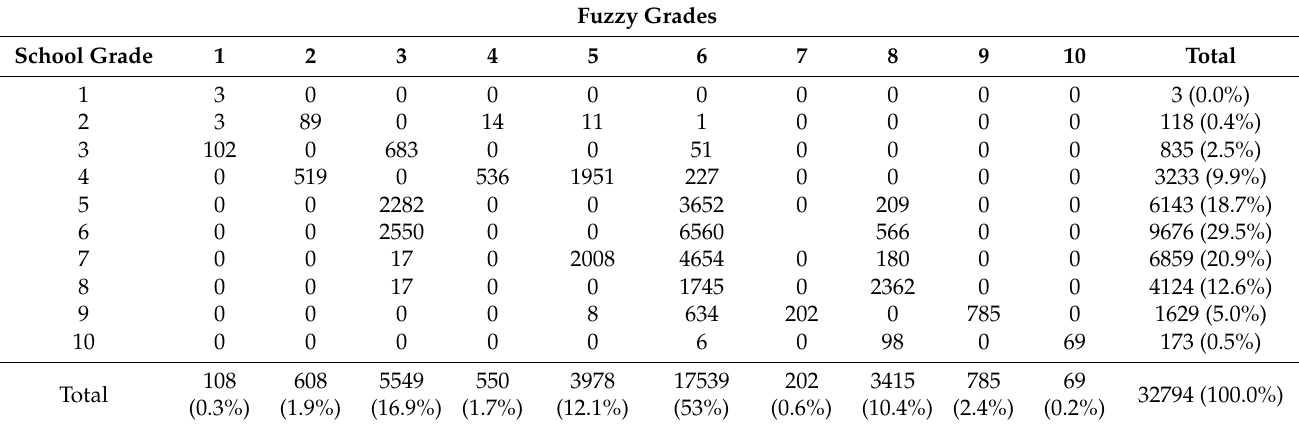
Table 10. The distribution of fuzzy grades among students with different school grades. Fuzzy